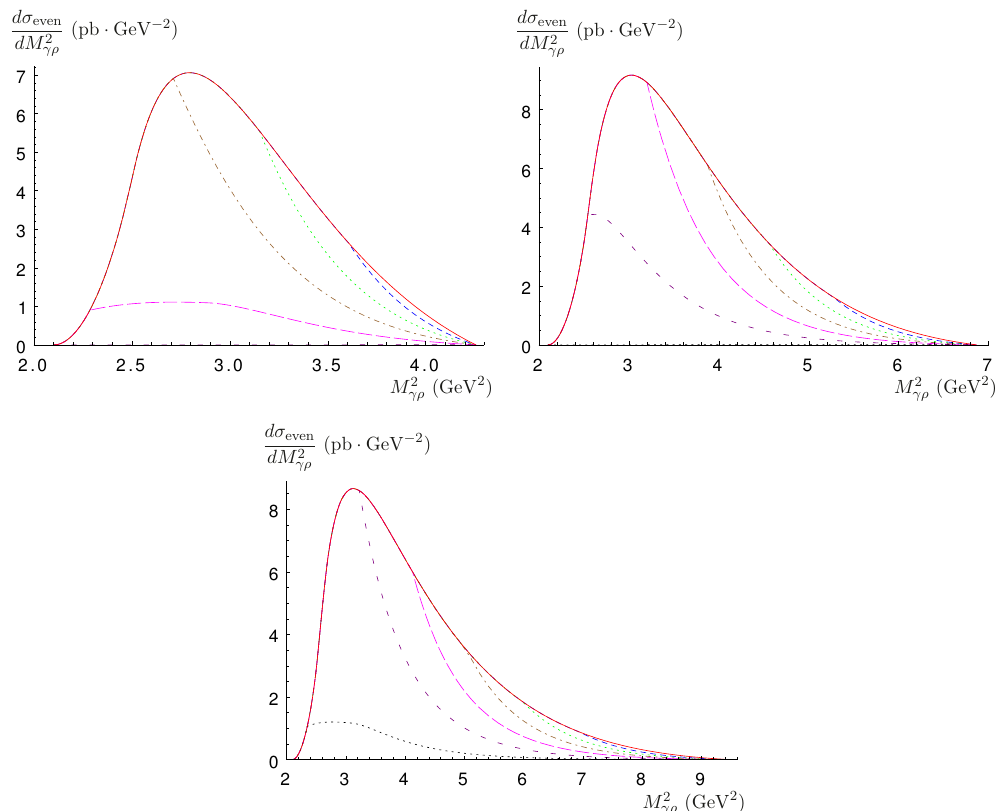
Figure 22 . The differential cross section dσ even . Solid red: no angular cut. Other curves show dM 2 γρ the effect of an upper angular cut θ for the out-going γ : 35 ◦ (dashed blue), 30 ◦ (dotted green), 25 ◦ (dashed-dotted brown), 20 ◦ (long-dashed magenta), 15 ◦ (short-dashed purple) and 10 ◦ (dotted black). Up, left: S γN = 10 GeV 2 . Up, right: S γN = 15 GeV 2 . Down: S γN = 20 GeV 2